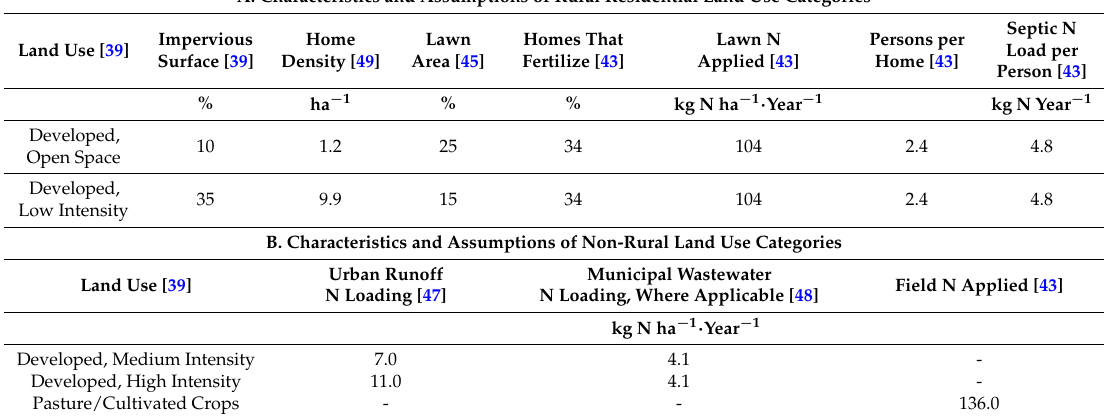
Table 2. Assumptions and rates for watershed nitrogen computations to